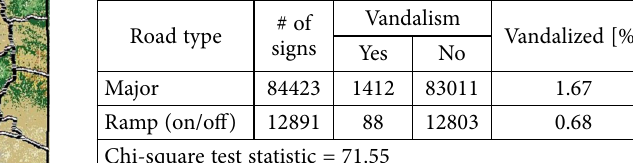
Table 8. Traffic sign vandalism by road